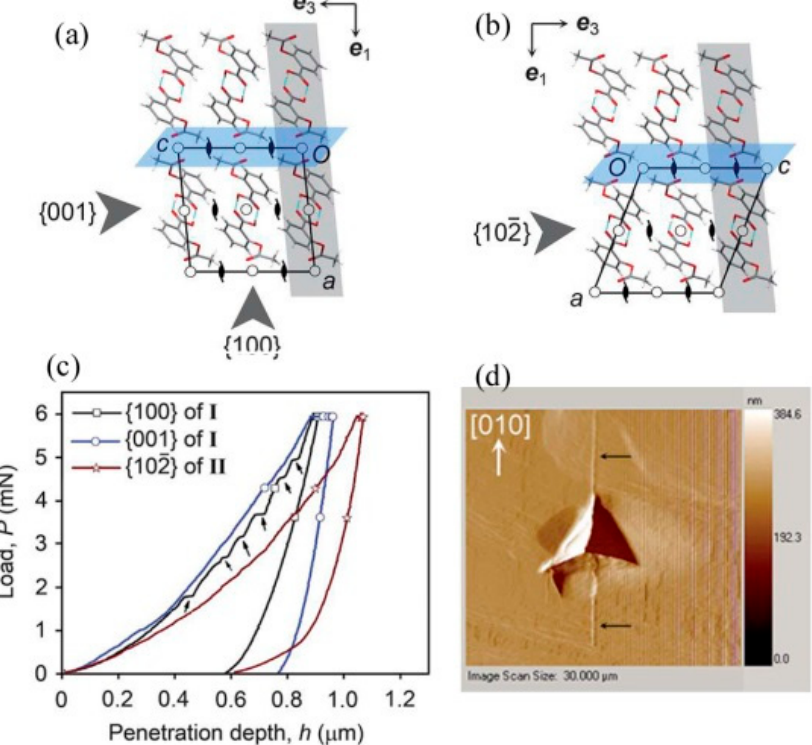
Figure 9. Crystal packing of the aspirin polymorphic forms: ( a ) form I, and ( b ) form II. The planes parallel to the {001} or {102} are highlighted by grey slabs and slip planes are colored blue. ( c ) P-h curves obtained from different faces of both forms, with pop-ins indicated by arrows. ( d ) Post-indent image obtained from the {100} of form I shows a crack running along the <010> at higher loads. (Reproduced with permission from the Royal Society of Chemistry, Reference 89).